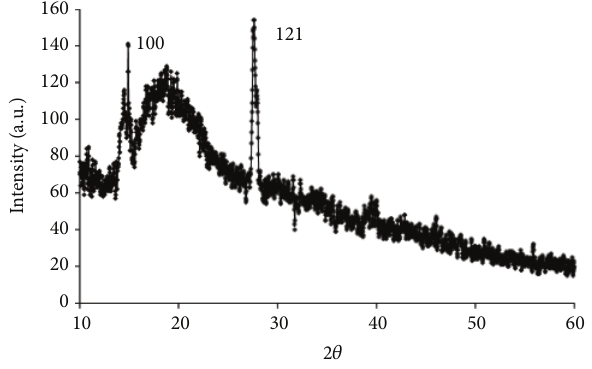
Figure 7: XRD pattern of complexed